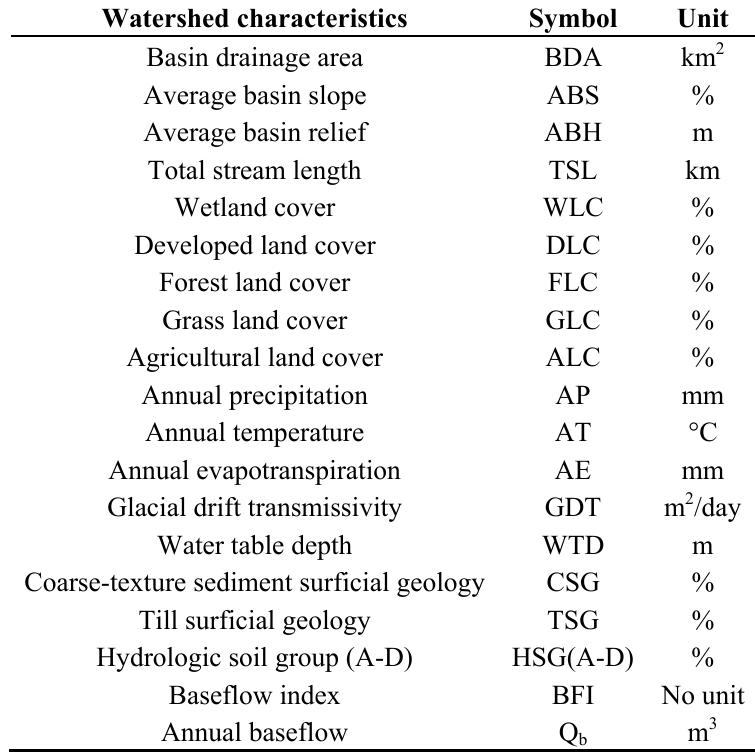
Table 2. Abbreviation and unit of all watershed characteristics for multiple